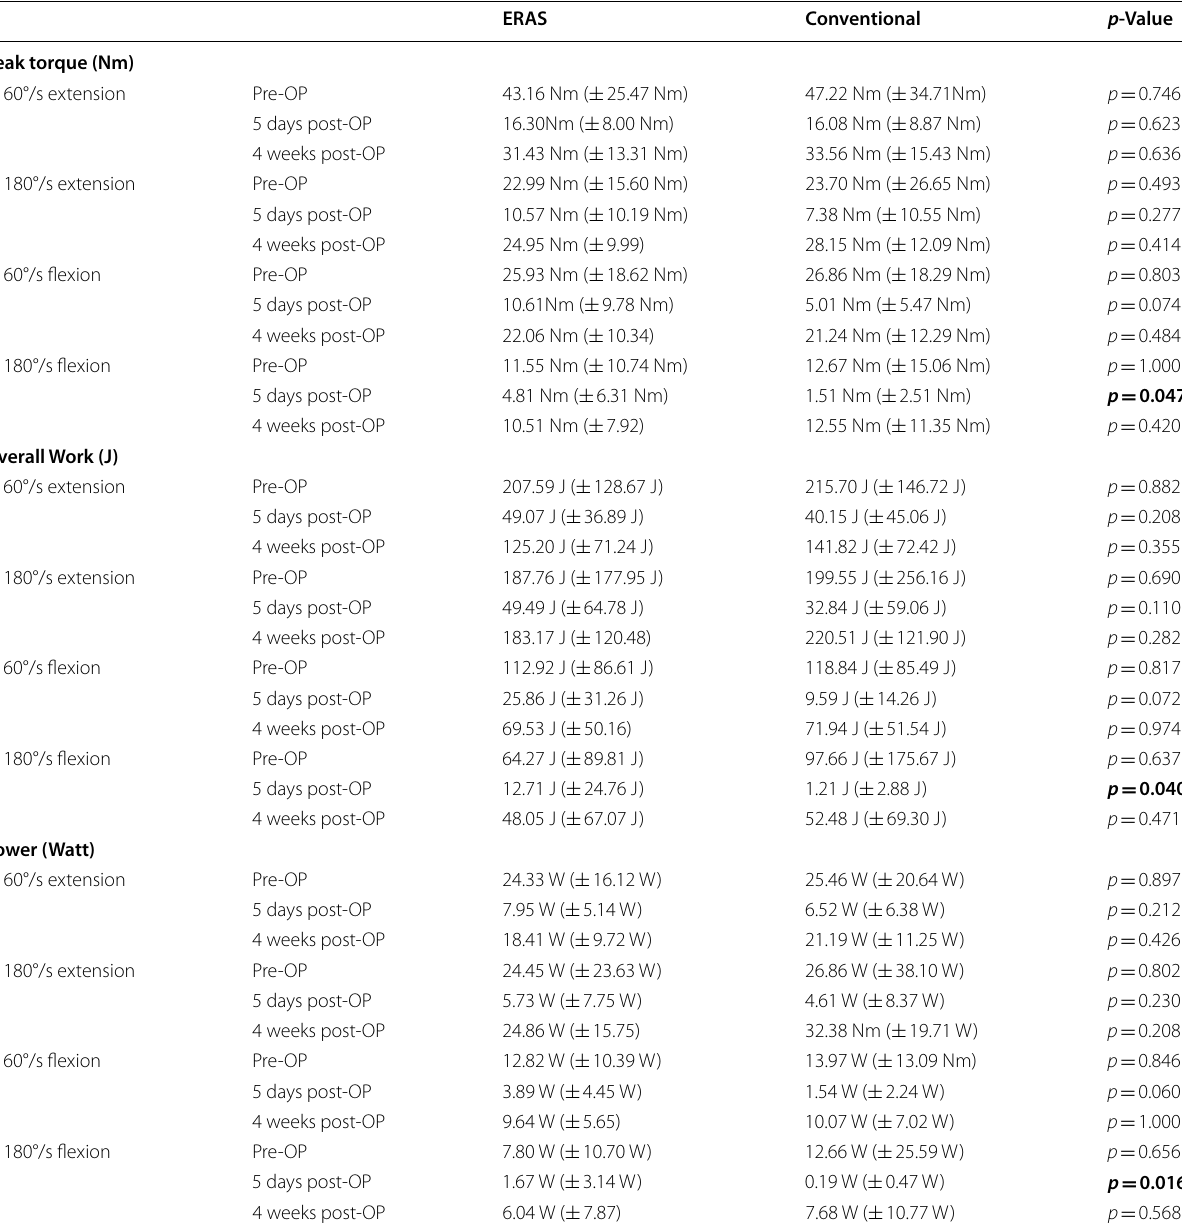
Table 3 Mean value and standard deviation of peak torque (Nm), work (J) and Power (W) preoperatively as well as after a follow up of 5 days and 4 weeks after surgery with enhanced recovery or conventional